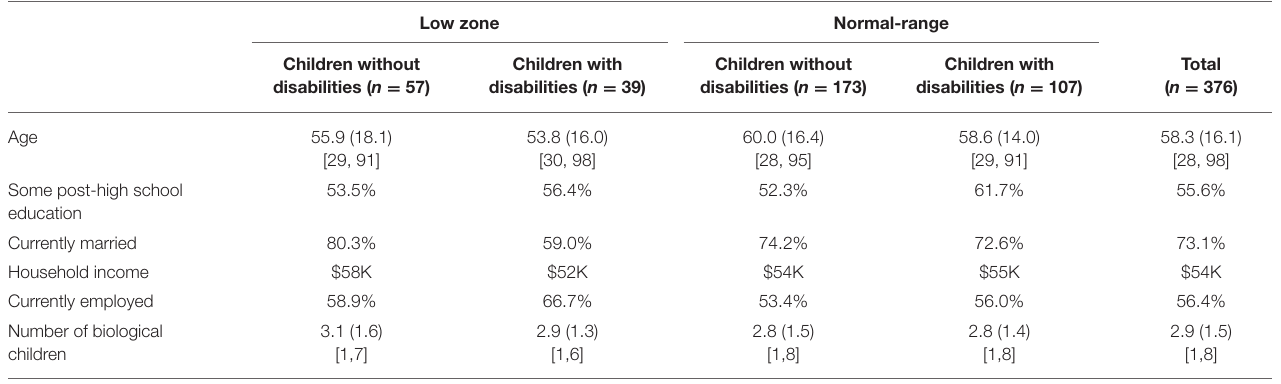
TABLE 2 | Demographic characteristics of mothers by CGG category and stressful parenting